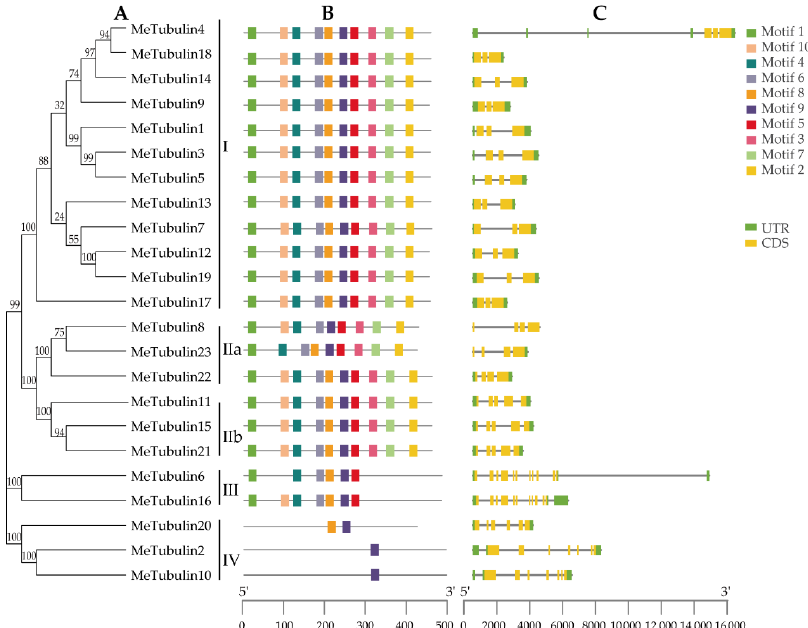
Figure 3. Phylogenetic relationships, gene structure, and conserved motifs in tubulin genes from cassava. ( A ) The phylogenetic tree was constructed according to the full-length sequences of cassava tubulin using MEGA 7.0. (B ) The motif composition of cassava tubulin. The motifs (numbers 1–10) are represented by rectangles of different colors. Supplementary Table S4 contains the amino acid sequence, E-value, and functional annotation of each motif. ( C ) Exon–intron organization of MeTubulins . Green rectangles represent untranslated 5 (cid:48) - and 3 (cid:48) -regions; yellow rectangle represents coding sequences Figure 7. Expression profiles of FtsZ2-1 gene in response to various stress treatments. Data were normalized to the tubulin gene and vertical bars indicate standard deviation. Asterisk (* significant and ** highly significant) denote significant var- (CDS); introns are represented by black lines. The scale at the bottom is to estimate the length of the iation ( p < 0.05).